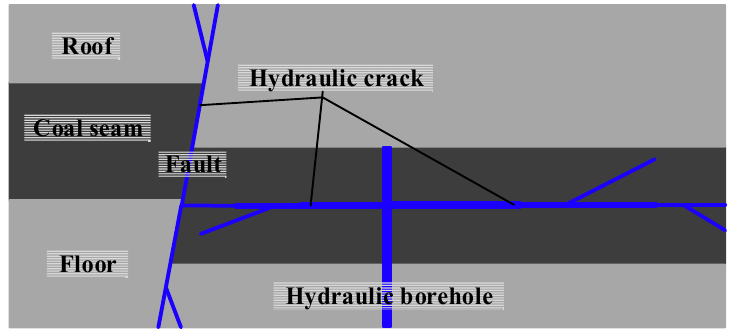
Figure 7. Diagram of hydraulic fracturing around a fault.